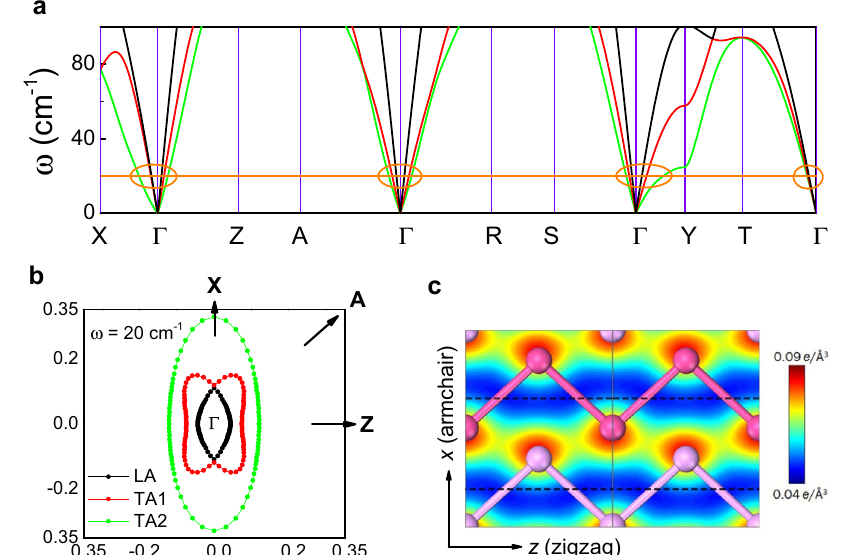
red) are almost degenerate along x . Energy transfer across phonon branches can be affectedbythe magnetic fi eld. c Spatialdistributionofchargeconcentrationinbulk BP 35 . Note the x – z anisotropy. The ( c ) is adapted from ref. 35 , Royal Society of